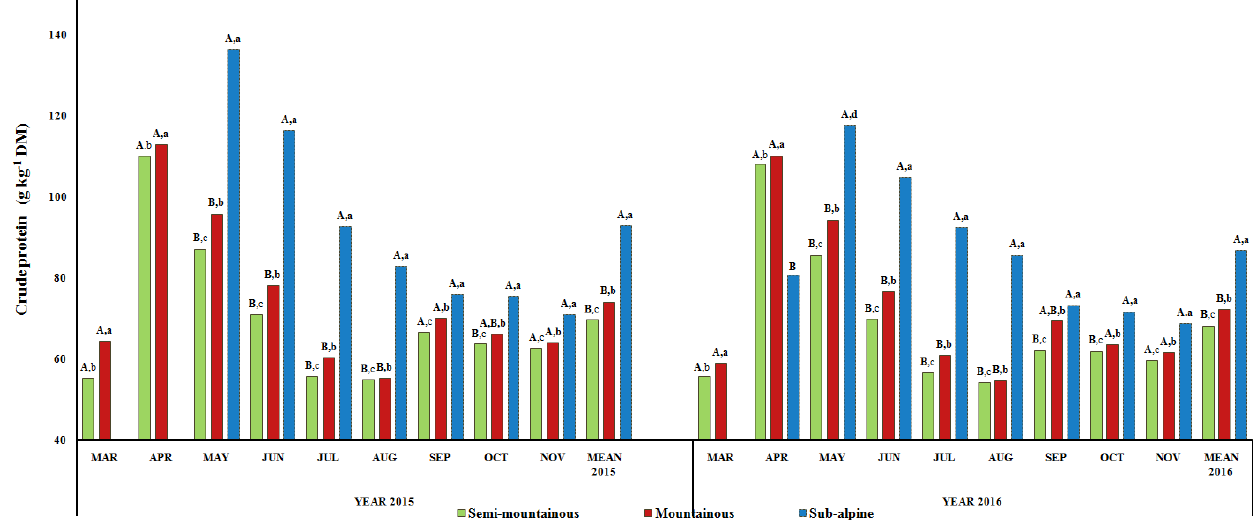
Figure 2. Interannual and monthly variation in herbage crude protein (CP; gkg − 1 DM) content of the semi-mountainous, mountainous and sub-alpine grasslands in the Florina Prefecture, northern Greece. Means of the three grasslands between the 2-year experimental period followed by different letters (a–d) along the corresponding bar differ at P < 0 . 05. Means of the three grasslands in the same year of the experimental period followed by different capital letters (A–C) along the corresponding bar differ at P < 0 .